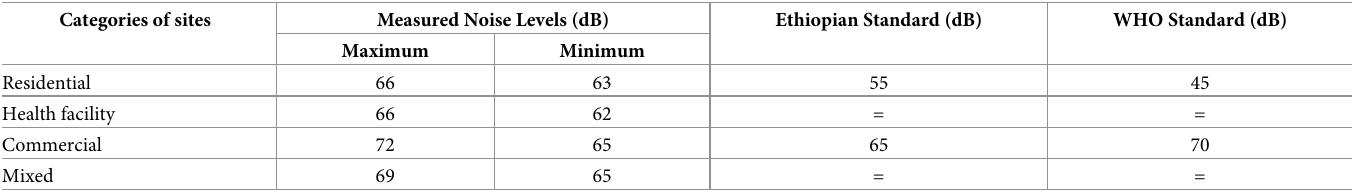
Table 1. A week average measurement of noise pollution levels (dB) in the four sites of Dessie city, northeast Ethiopia, in comparison to the Ethiopian and WHO standards [24]. Categories of